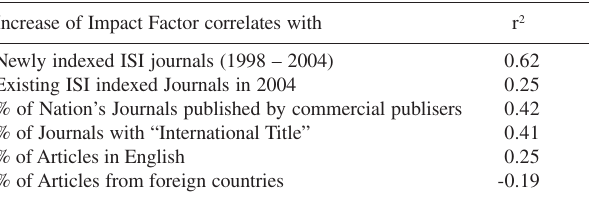
Table 1 - Factors affecting impact of journals published in developing coutries (adpated from Meneghini R, unpublished